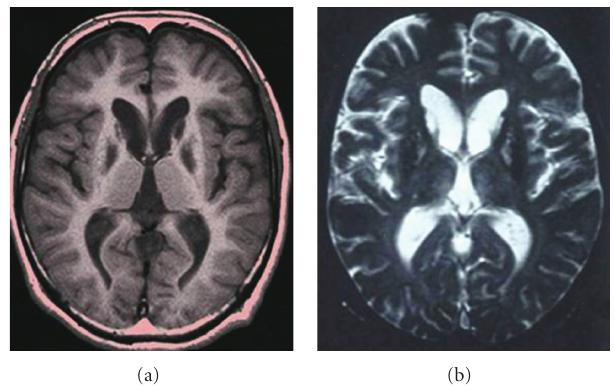
Figure 1: Axial section at the level of the basal ganglia in the patient at 35 years of age. (a) A T1-weighted image (TR 400 msec/ TE 14msec) shows symmetrical hypointense signals in the head of the caudate nucleus and globus pallidus. (b) A T2-weighted image (TR 800 msec/TE 30msec) shows hypointense changes in the lenticular nucleus. Hyperintense signals can be observed in the putamen and the head of the caudate